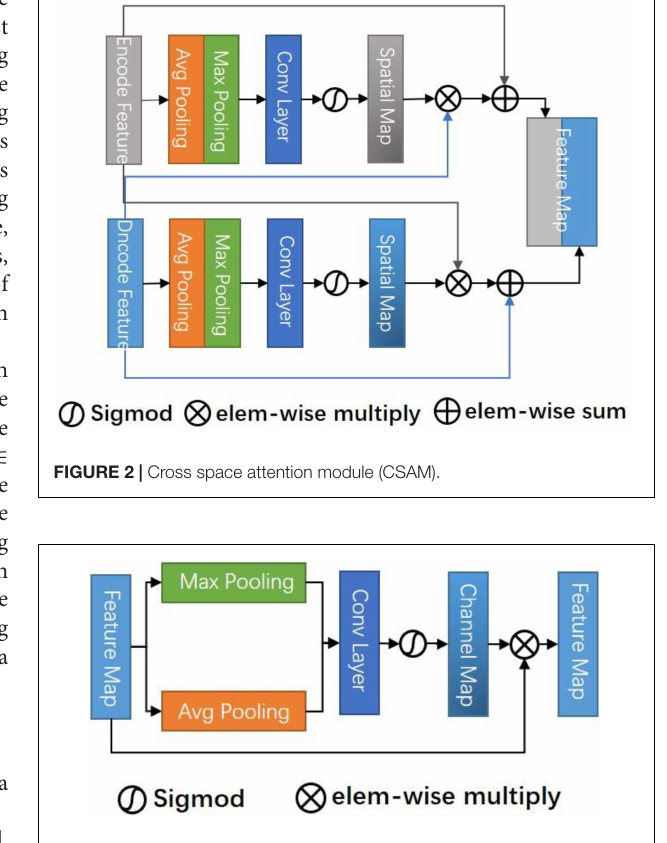
FIGURE 3 | Channel attention module